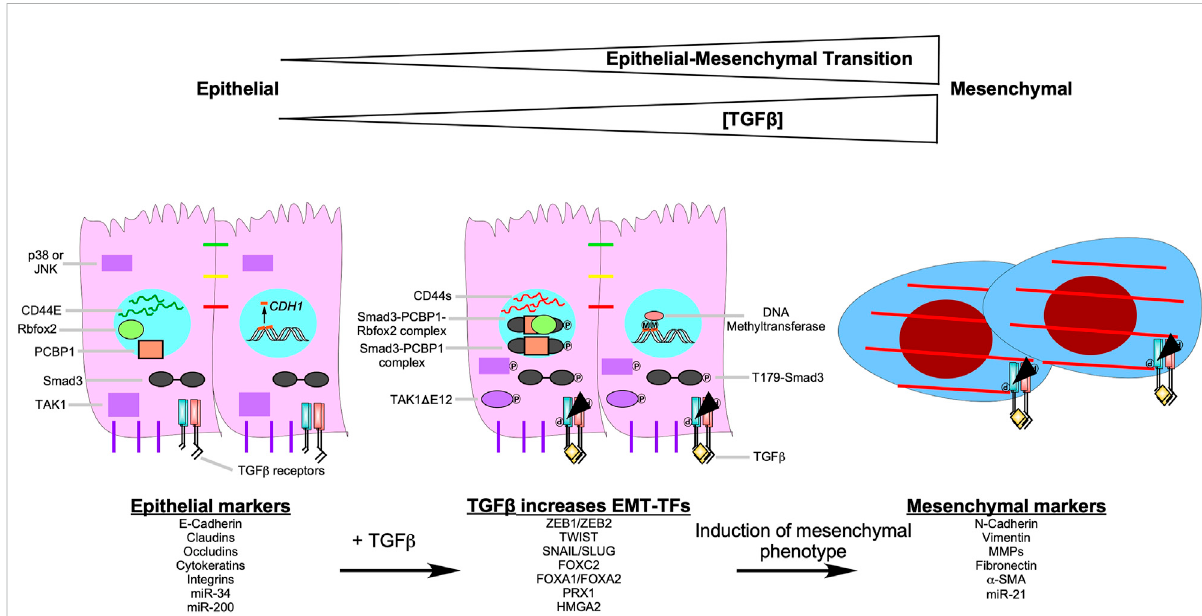
FIGURE 9 TGF β signalling pathways that induce epithelial-mesenchymal transition. As the concentration of transforming growth factor- β (TGF β ) increases, theepithelial-mesenchymal transition (EMT) program becomes more pronounced.After TGF β binds tothe TGF β receptors, itupregulates EMT-transcription factors (EMT-TFs), such as Snail Family Transcriptional Repressor one and 2 (SNAIL/SLUG), Zinc Finger E-box Binding Homeobox one and 2 (ZEB1/ZEB2), Twist-related Protein 1 (TWIST1), Forkhead box C2 (FOXC2), Forkhead box A1 (FOXA1), Forkhead box A2 (FOXA2), Paired-related Homeobox 1 (PRX1), and High Mobility Group AT-hook 2 (HMGA2).EMT-TFs downregulate epithelial markers ((E-Cadherin, claudins, occludins, cytokeratins, integrins, microRNA (miR)-34, and miR-200)) and upregulate mesenchymal markers ((N-Cadherin, vimentin, matrix metalloproteinases (MMPs), fi bronectin, α -smooth muscle actin ( α -SMA), and miR-21)). TGF β induces EMT by increasing DNA methyltransferase activity. In the presence of TGF β , DNA methyltransferase methylates (M) the promoters of epithelial genes, such as Cadherin 1 ( CDH1 ). Also, when TGF β receptortypeIphosphorylatesSmad3 atthreonine 179(T179-Smad3), itmay associate with theRNA-binding proteinpoly (RC)binding protein 1 (PCBP1). Smad3-PCBP1 complexes alter CD44 splicing from CD44E, which is found in epithelial cells, to CD44s. CD44s splice variants modulate cell-celladhesiontopromoteEMT.TheSmad3-PCBP1complexassociatedwithRbfox2thatmediatesalternativesplicingofTGF β -activatedkinase1 (TAK1) to favour TAK1 Δ Glu 12 (TAK1 Δ E12) variants. TAK1 Δ E12 is constitutively active, which leads to the constitutive phosphorylation of p38 MAPK (p38) and cJun N-terminal Kinase (JNK). P38 and JNK upregulate genes that promote